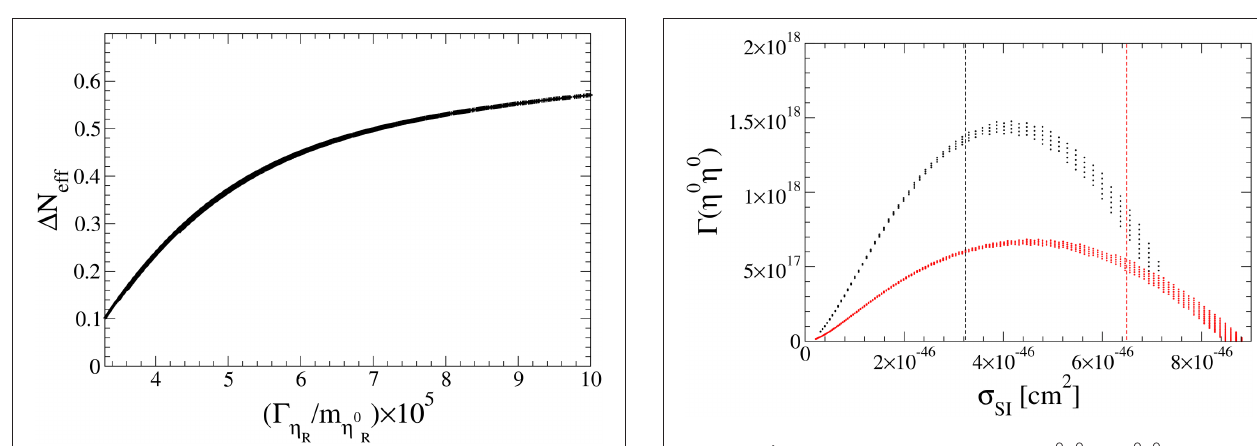
, where we have used the same R